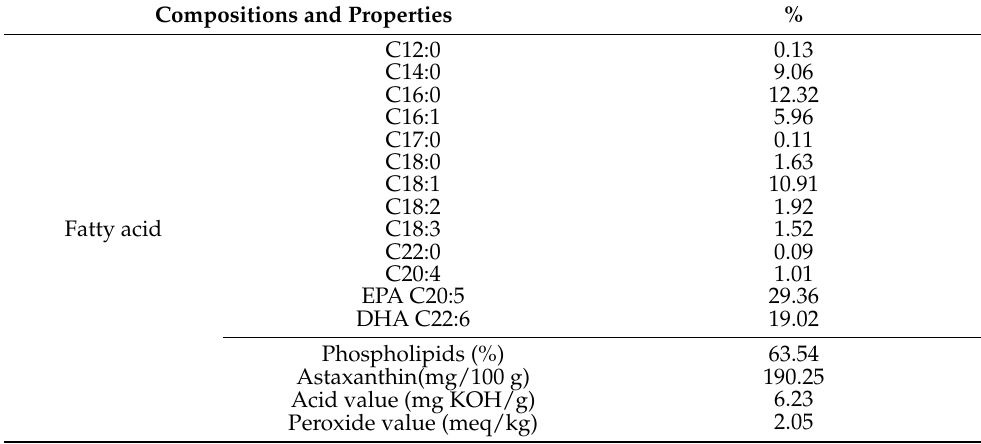
Table 3. Physicochemical properties and fatty acid compositions of